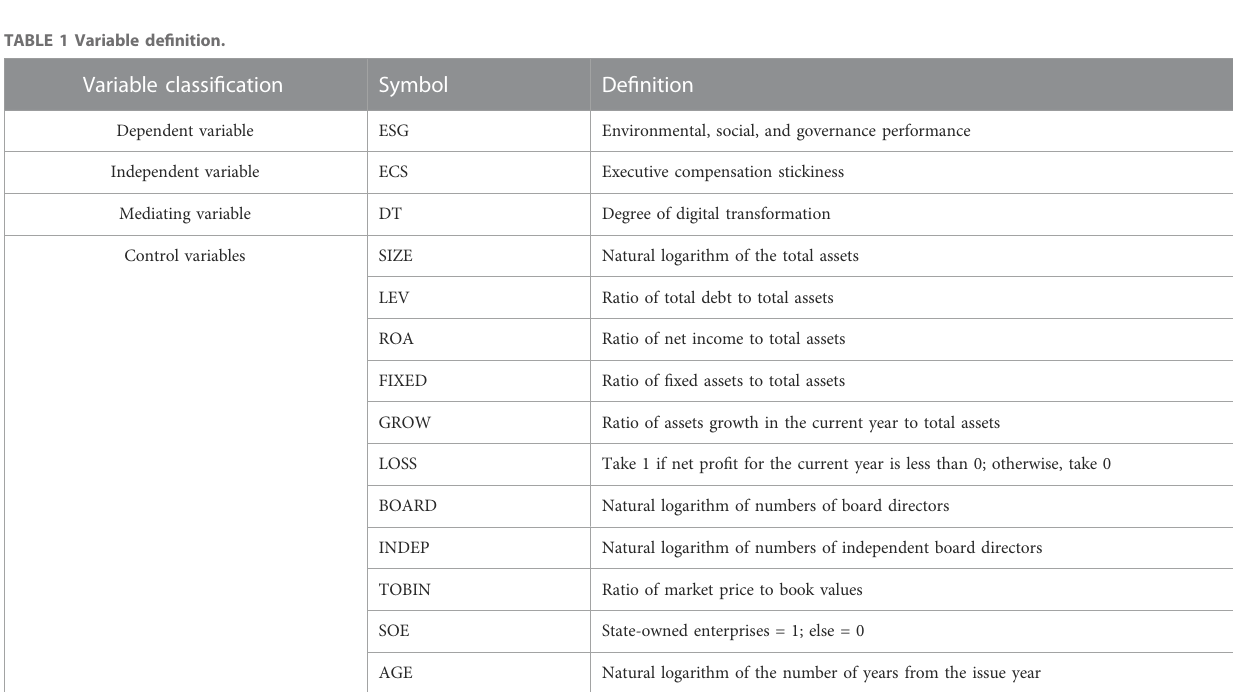
TABLE 1 Variable de fi